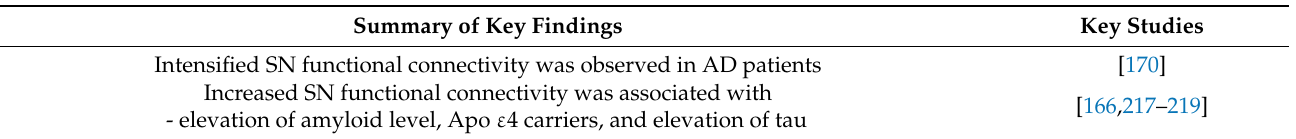
Table 6. Summary of key findings of main rs-fMRI studies associated with the salience network (SN) in Alzheimer’s disease (AD) and mild cognitive impairment (MCI) patients included in the review.